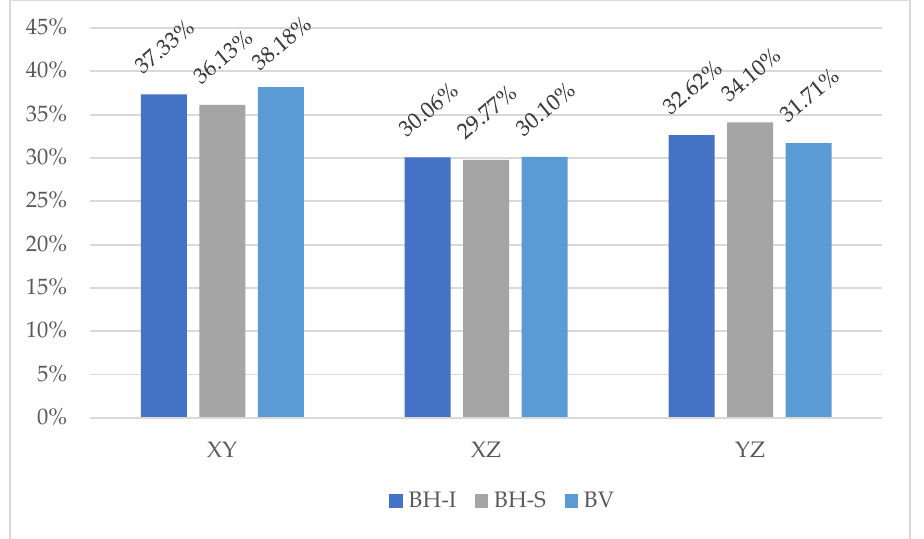
Figure 12. Distribution of fibres in each plane.